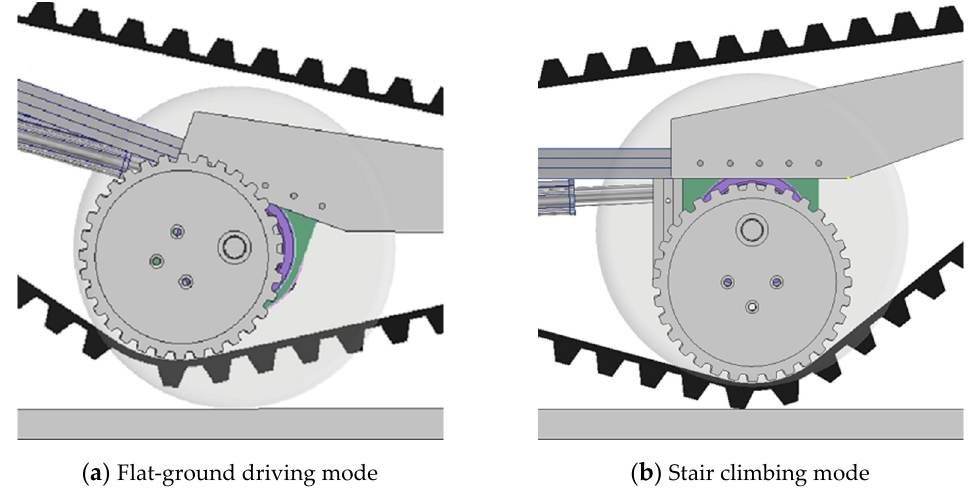
Figure 6. Comparison between flat-ground driving and stair-climbing modes. ( a ) Flat-ground driving mode. ( b ) Stair climbing mode.